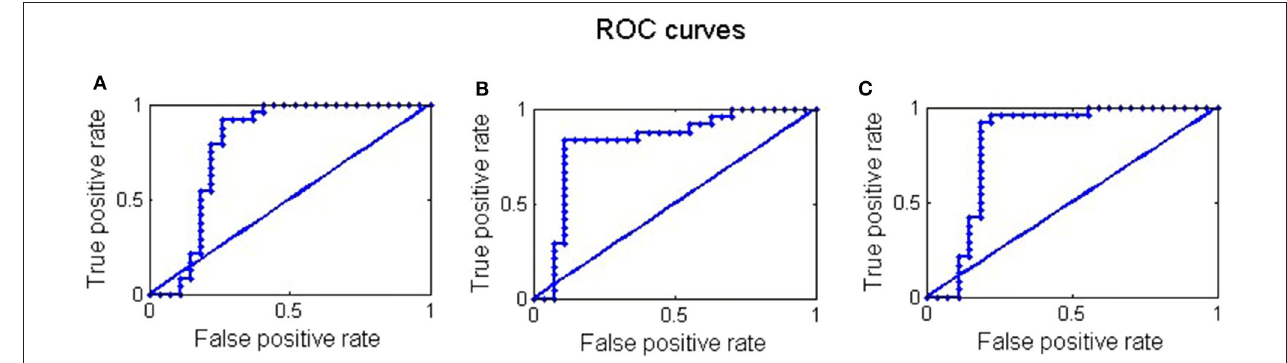
FIGURE 9 | ROC curves of the linear SVM classifier using (A) intra-in IFS of the vPCC_L, (B) intra-in + out IFS of the PCC_L, and (C) intra + inter-out IFS of the PCC_R within the DN as classification features. PCC, posterior cingulate cortex; vPCC, ventral posterior cingulate